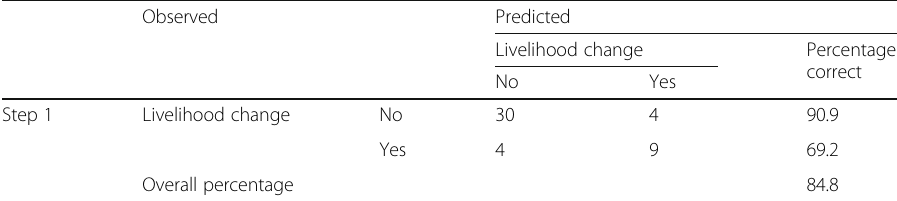
Table 16 Classification table (the cut value is